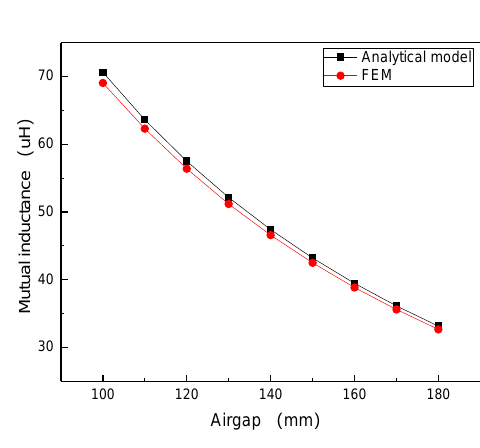
Figure 9. Mutual inductance versus air gap.